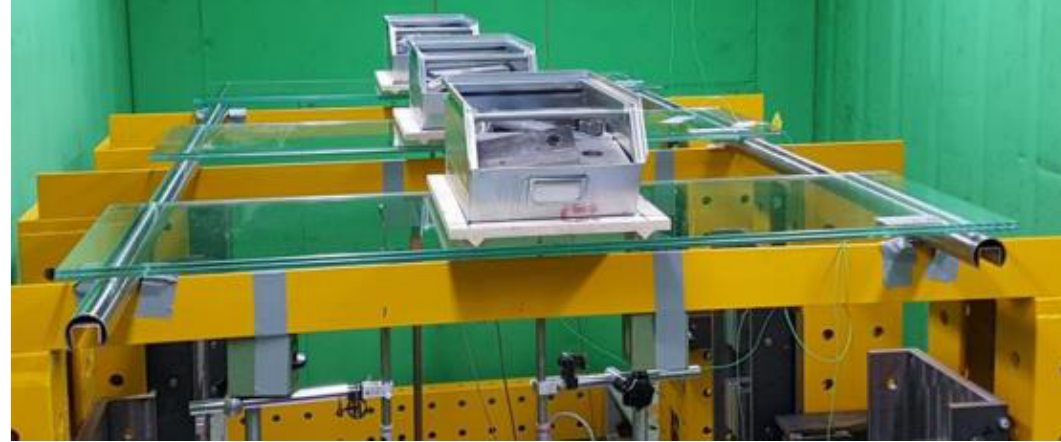
Fig. 2 Four-point bending verification set-up in temperature chamber (picture courtesy of Institute of Structural Engineering, University of the German Armed Forces, München,